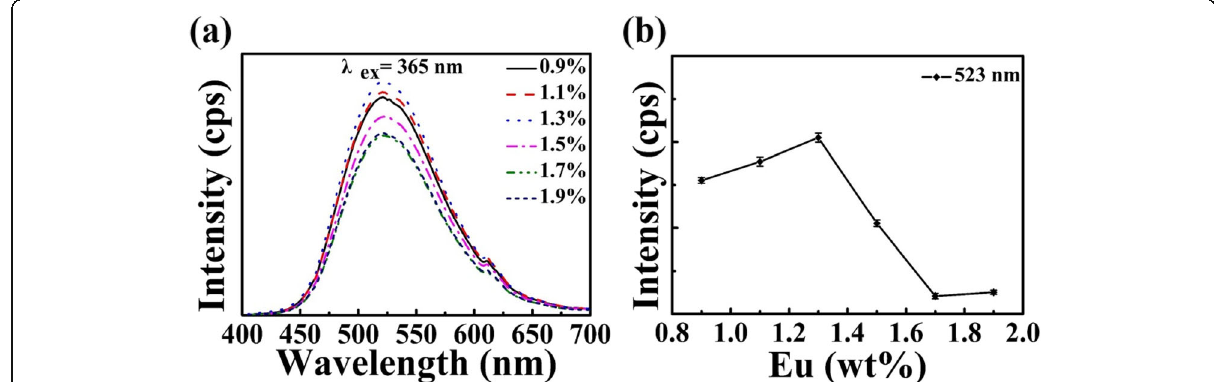
Fig. 5 a PL emission spectra and b the relative PL intensity vary with the concentration of Eu element for zeolite-3A: 1.3 wt% Eu phosphors ( x = 0.9~1.9) sintered at 1400 °C for 3